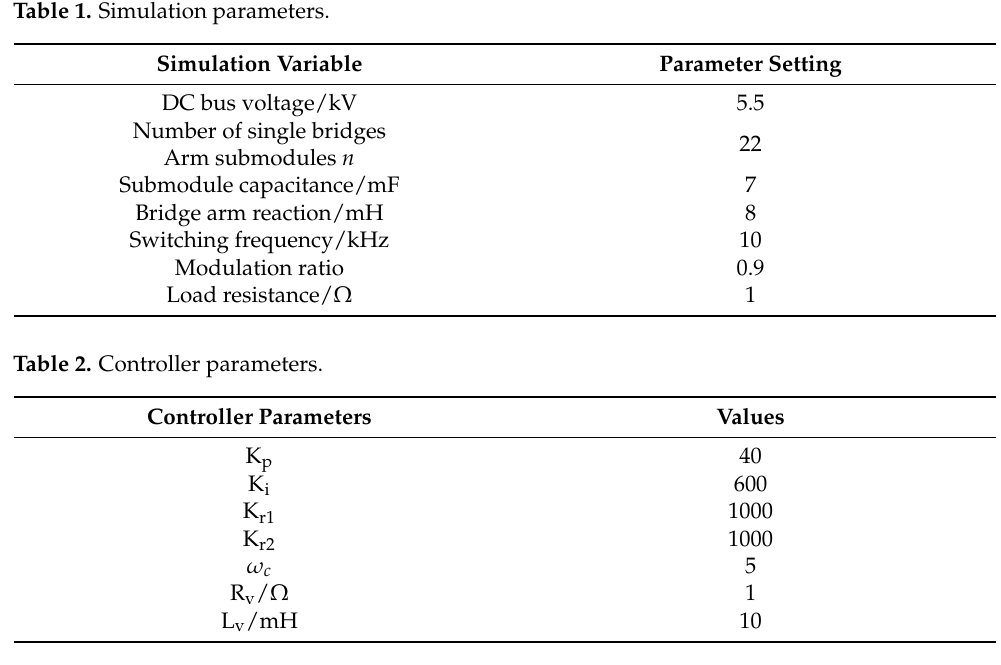
Figure 6. Structural diagram of the PIR virtual impedance controller.